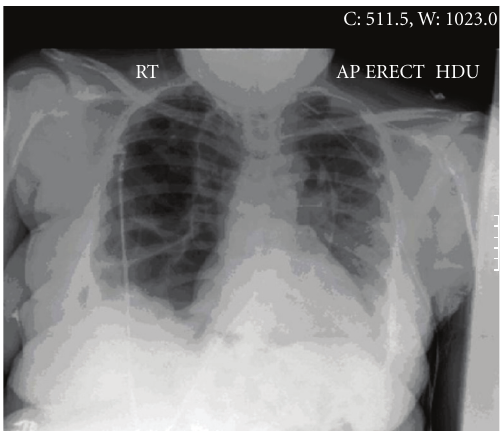
Figure 1: Pnemothorax postchest drains insertion, new left chest drain in situ. There has been good re-expansion of the left lung. No definite right pneumothorax seen.